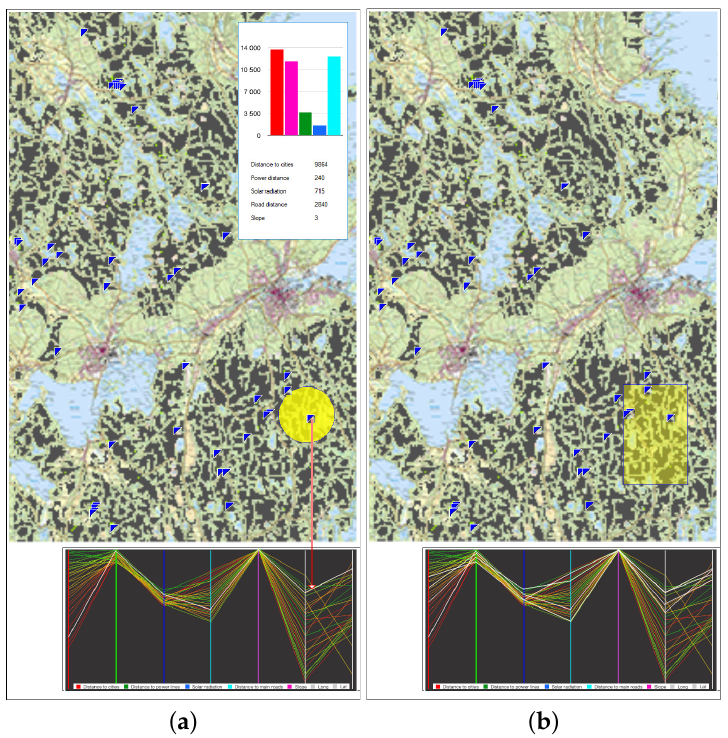
Figure 8. The interaction between the parallel coordinates plot and the geomap. When an alternative is selected in the plot, it is highlighted in the geomap. Selecting the alternative in the geomap opens a “detail-on-demand” window ( a ). When an area is selected in the geomap, all acceptable alternatives within the selected area are highlighted white in the parallel coordinates plot ( b